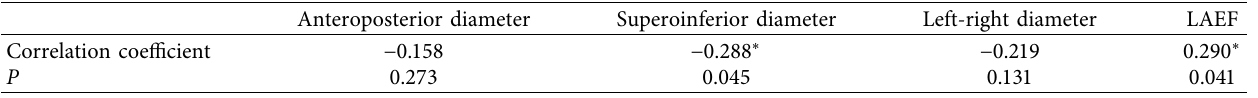
Table 3: Correlation analysis of postoperative sinus recovery, left atrial structure, and left atrial ejection fraction. Anteroposterior